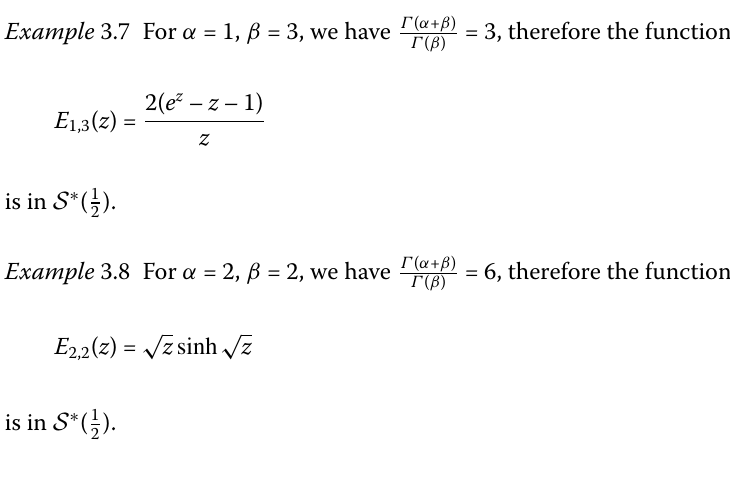
= 3, therefore the function Γ ( β )